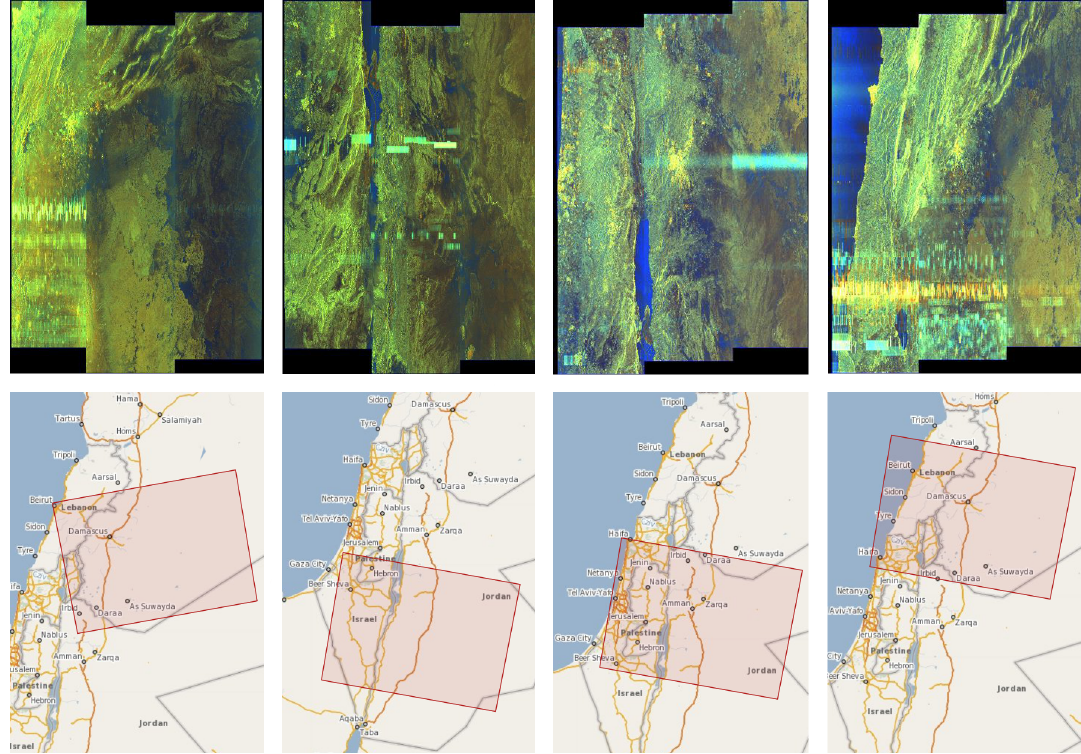
Figure 3. Examples of different forms of RFI artifacts (and their localization) included in the training